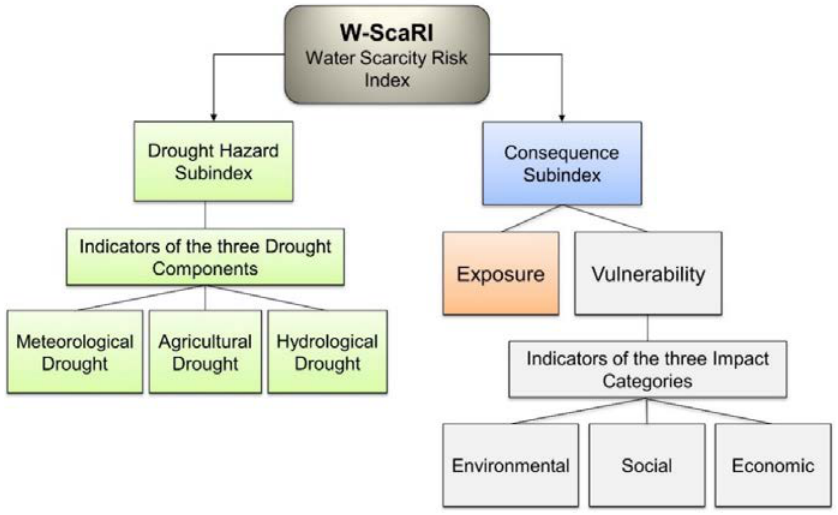
Figure 1. Water Scarcity Risk Index ( W-ScaRI ) representation.